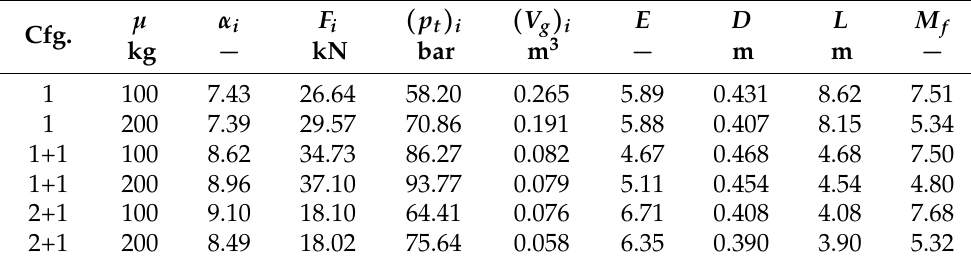
Table 7. Optimal design and performance of the hybrid-powered accelerator. D and L are the engine diameter and length. In the first column (Cfg.) the configurations are reported as: (1) single stage, (1+1) two stage/single engine per stage, (2+1) two stage/two engines in the first stage.